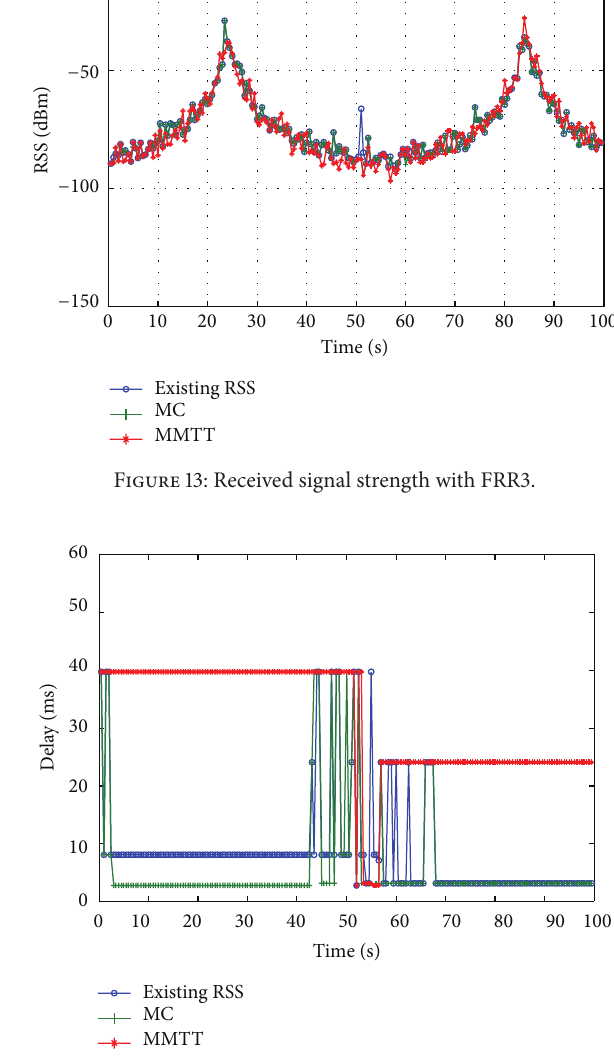
Figure 14: Delay without